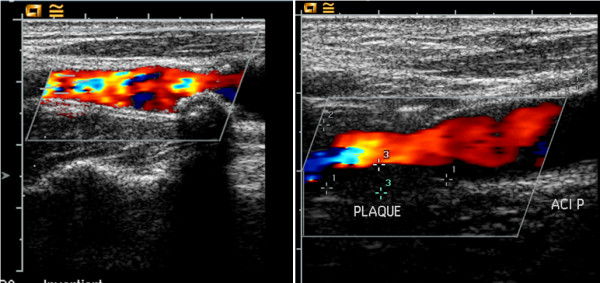
Shown are two plaque types with different plaque scores. The left plaque would be classified as stenosis < 40%; intermediate echogenicity; heterogenous texture and irregular surface. Plaque score: 4; reversed score: 4. The right plaque would be classified as stenosis <40%, low echogenicity, homogeneous texture and smooth surface. Plaque score: 1, reversed score: 4.